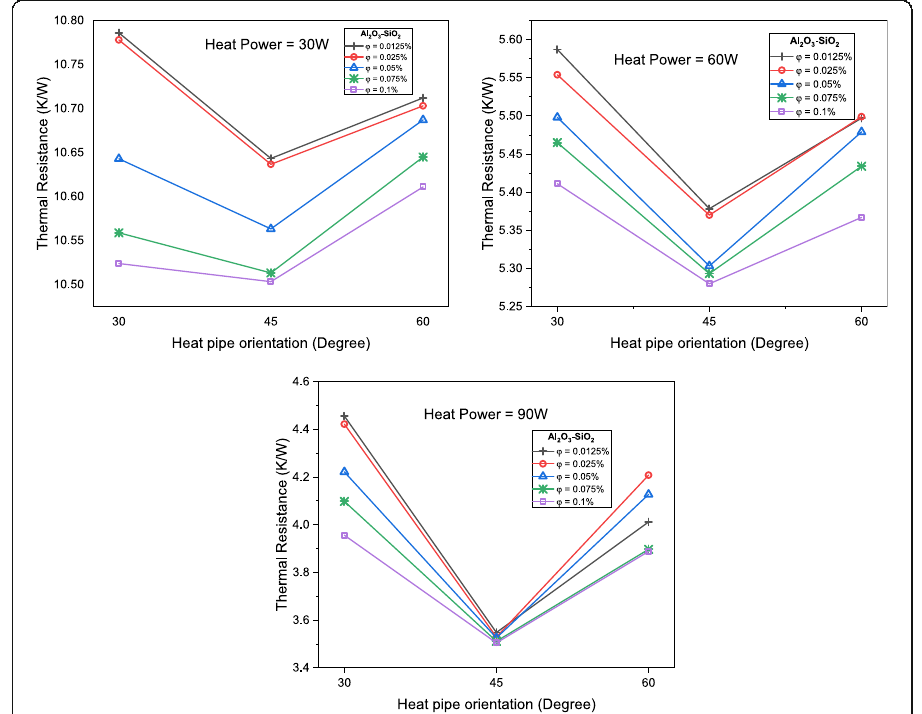
Fig. 5 The effect of heat pipe orientation on thermal resistance at a 30 W, b 60 W, and c 90 W